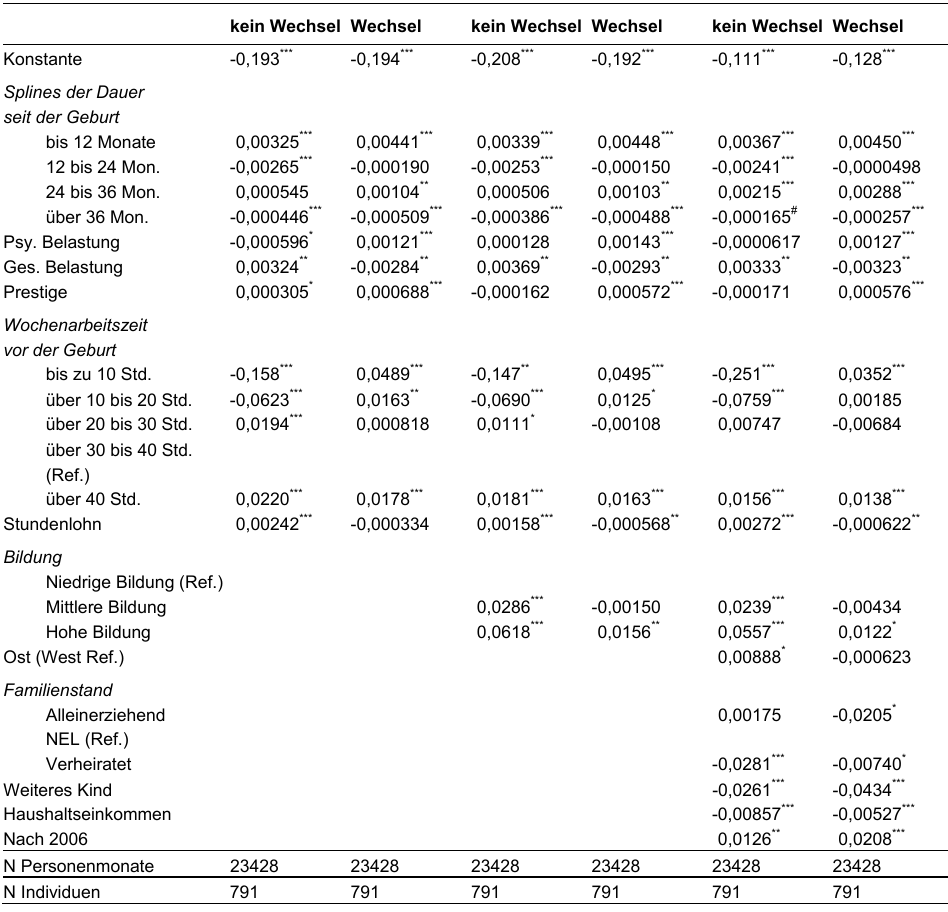
Tabelle 2 : Competing Risk-Modell, Average Marginal